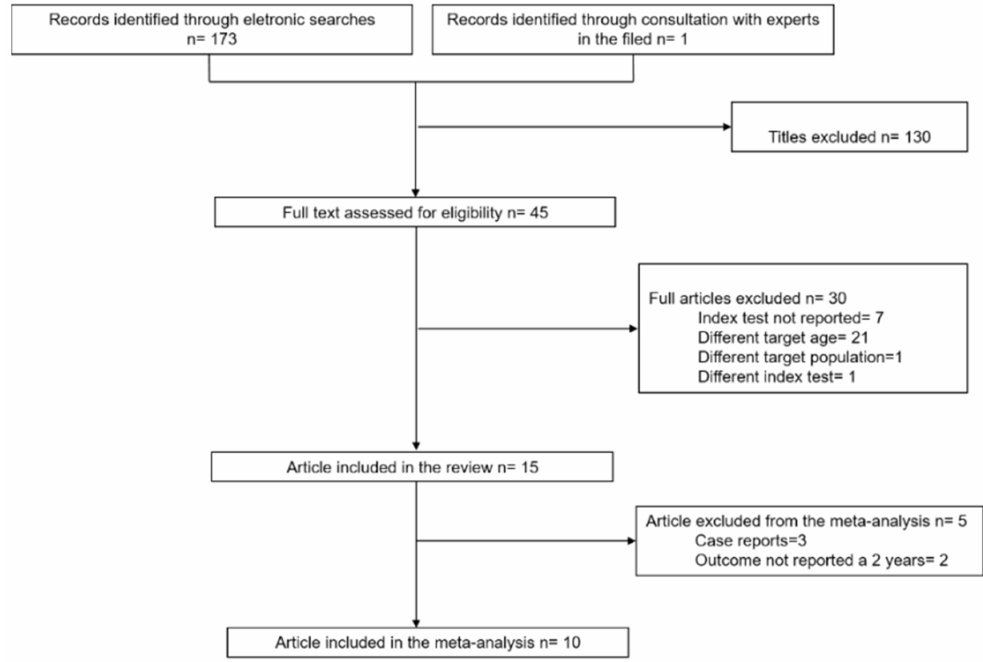
Figure 1. PRISMA flow diagram of study